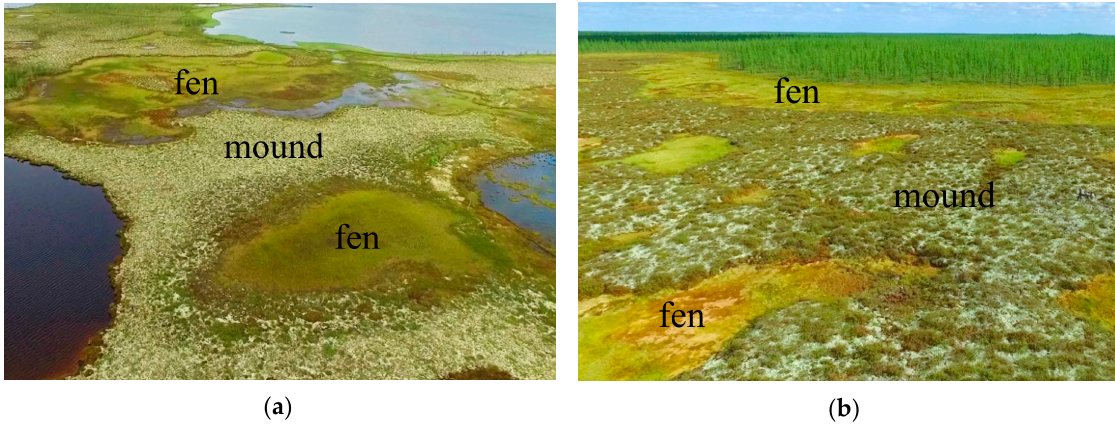
Figure 2. Landscapes of raised-mound bog: ( a ) Khanymey key site, northern taiga—the flat mound fenny-lake microlandscape on the flat interfluve; ( b ) Urengoy key site, forest-tundra—the gently convex fenny mound microlandscape.